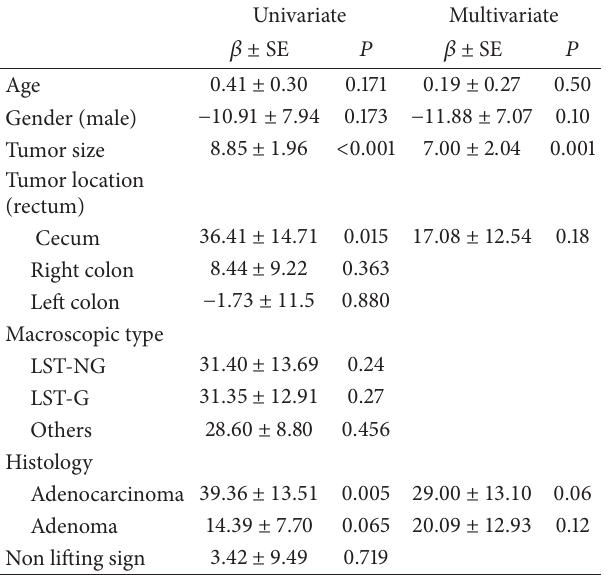
Table 3: Univariate and multivariate analysis of factors affecting ESD procedure time.